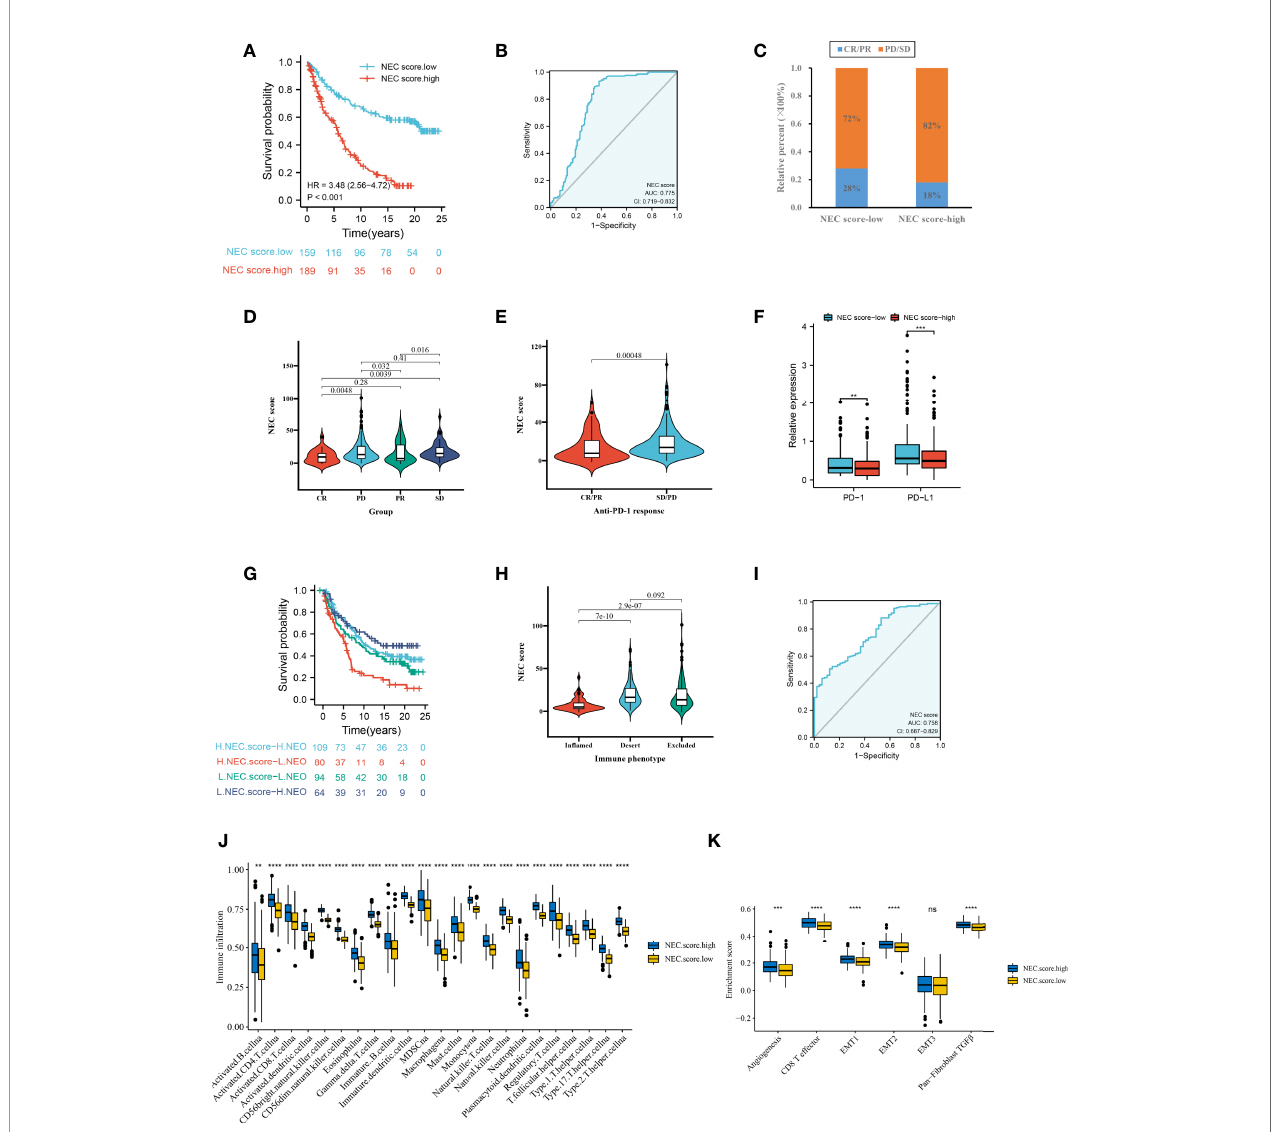
FIGURE 8 | NEC score in the role of anti-PD-1/L1 immunotherapy. (A) Survival analyses for low and high NEC score patient groups in the anti-PD-L1 immunotherapy cohort using Kaplan-Meier curves (IMvigor210 cohort). (B) The predictive value of NEC score in IMvigor210 cohort. (C) The proportion of patients with response to PD-L1 blockade immunotherapy in low or high NEC score groups. SD, stable disease; PD, progressive disease; CR, complete response; PR, partial response. (D) Differences in NEC score among distinct anti-PD-1 clinical response groups (Student ’ s t test). (E) Distribution of NEC score in distinct anti-PD- L1 clinical response groups (Student ’ s t test). (F) Differences in checkpoint expression between low and high NEC score groups (Student ’ s t test). The asterisks represented the statistical p-value (*P < 0.05; **P < 0.01; ***P < 0.001). (G) Survival analyses for patients receiving anti-PD-L1 immunotherapy strati fi ed by both NEC score and neoantigen burden using Kaplan-Meier curves. (H) Differences in NEC score between immune subtypes (Student ’ s t test). (I) The predictive value of the quanti fi cation of NEC patterns in patients treated with anti-PD-1/L1 immunotherapy . (J) The abundance of each TME in fi ltrating cell in high and low NEC score groups (Student ’ s t test). (K) Differences in stromaactivated pathways and abundance of regulatory T cells (considered as immune suppression) between low and high NEC score groups in anti-PD-L1 immunotherpy cohort (Student ’ s t